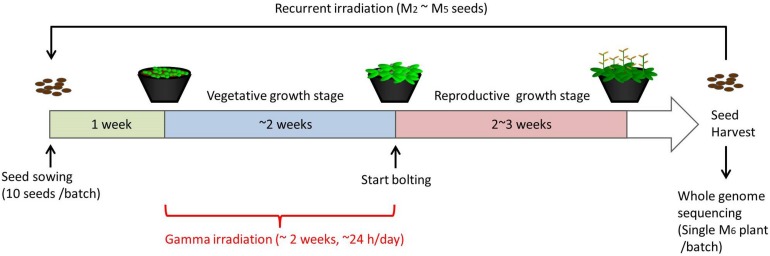
Schematic procedure of generating mutation accumulation lines. Arabidopsis seeds (10 seeds per batch) were sown and grown in a gamma ray environment from 1 week after sowing until plants started bolting (approximately 2 weeks). M2 seeds were harvested from each individual batch, and 10 of the M2 seeds were used for the next irradiation to obtain M3 seeds. This recurrent irradiation was performed until M6 seeds were obtained. A single M6 plants from each batch was grown and subjected to a whole-genome sequencing analysis.